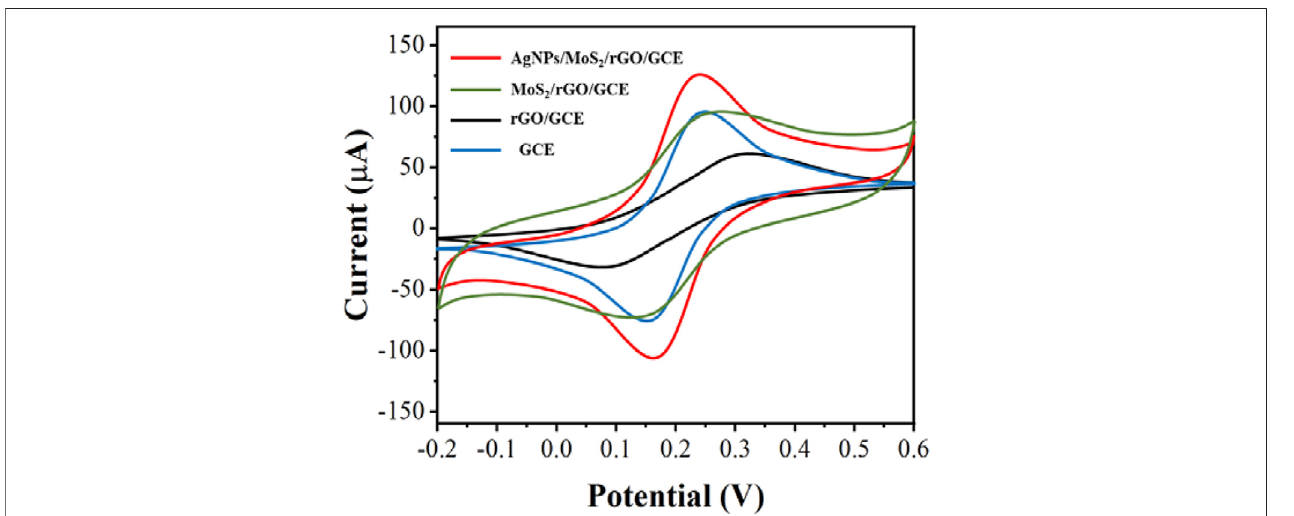
FIGURE 4 | EIS of GCE, rGO/GCE, MoS 2 /rGO/GCE and AgNps/MoS 2 /rGO/GCE in 5.0 mM [Fe(CN) 6 ] 3-/4- .